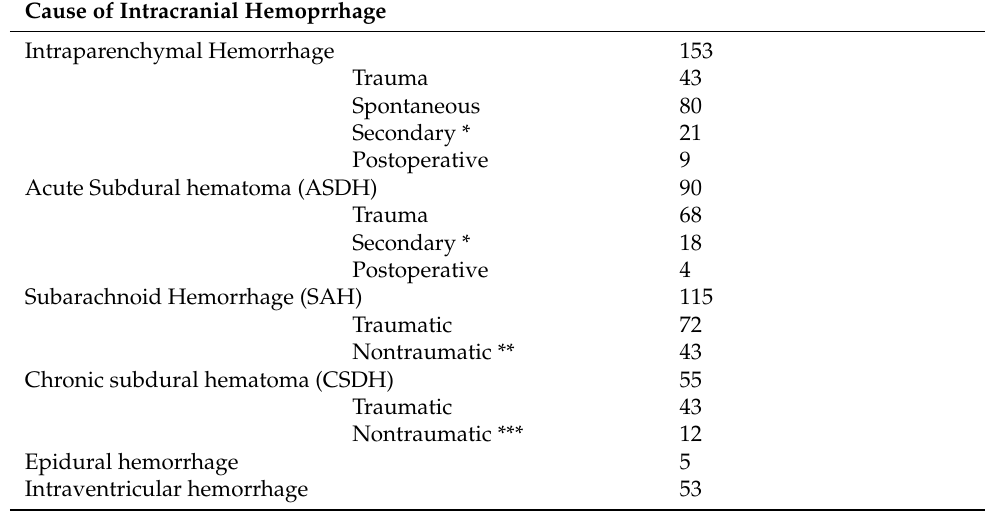
Table 2. Cause of Intracranial